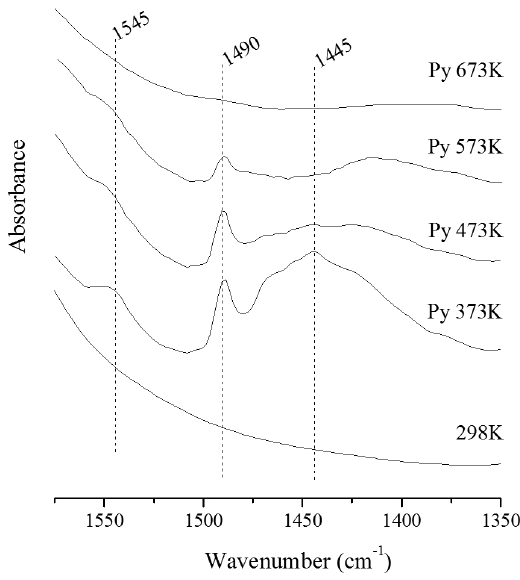
Figure 1. FT-IR spectra of pyridine adsorbed on the sample Al PILV. 13